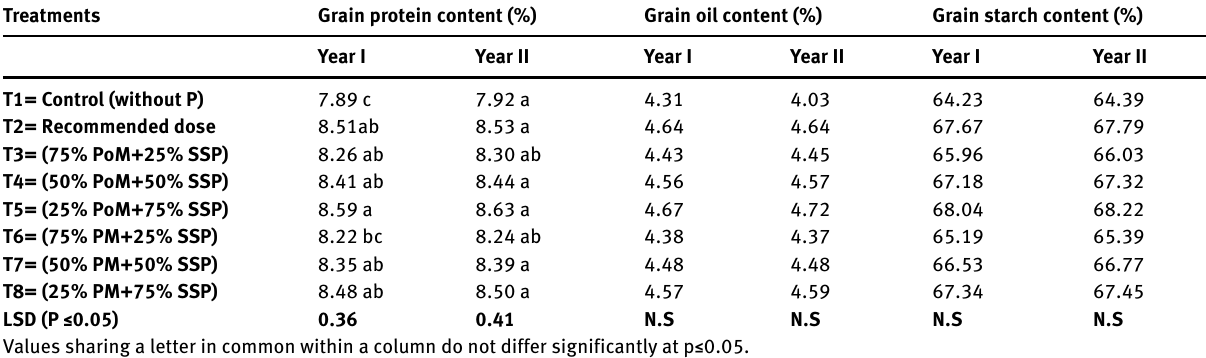
Table 5: Effect of integrated phosphorus management through organic manures and inorganic fertilizer on qualitative attributes of hybrid maize Treatments Grain protein content (%)